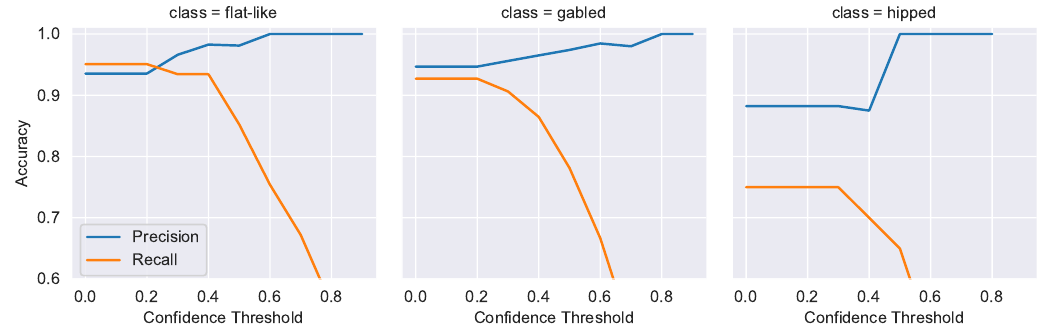
Figure 15. Test Set 2 confidence threshold impact on precision and recall for multiple